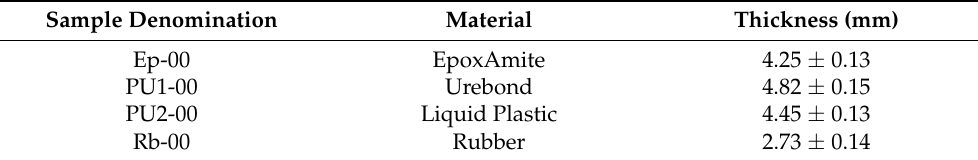
Table 2. Disk samples (30 mm diameter) of raw materials for ultrasonic characterization.